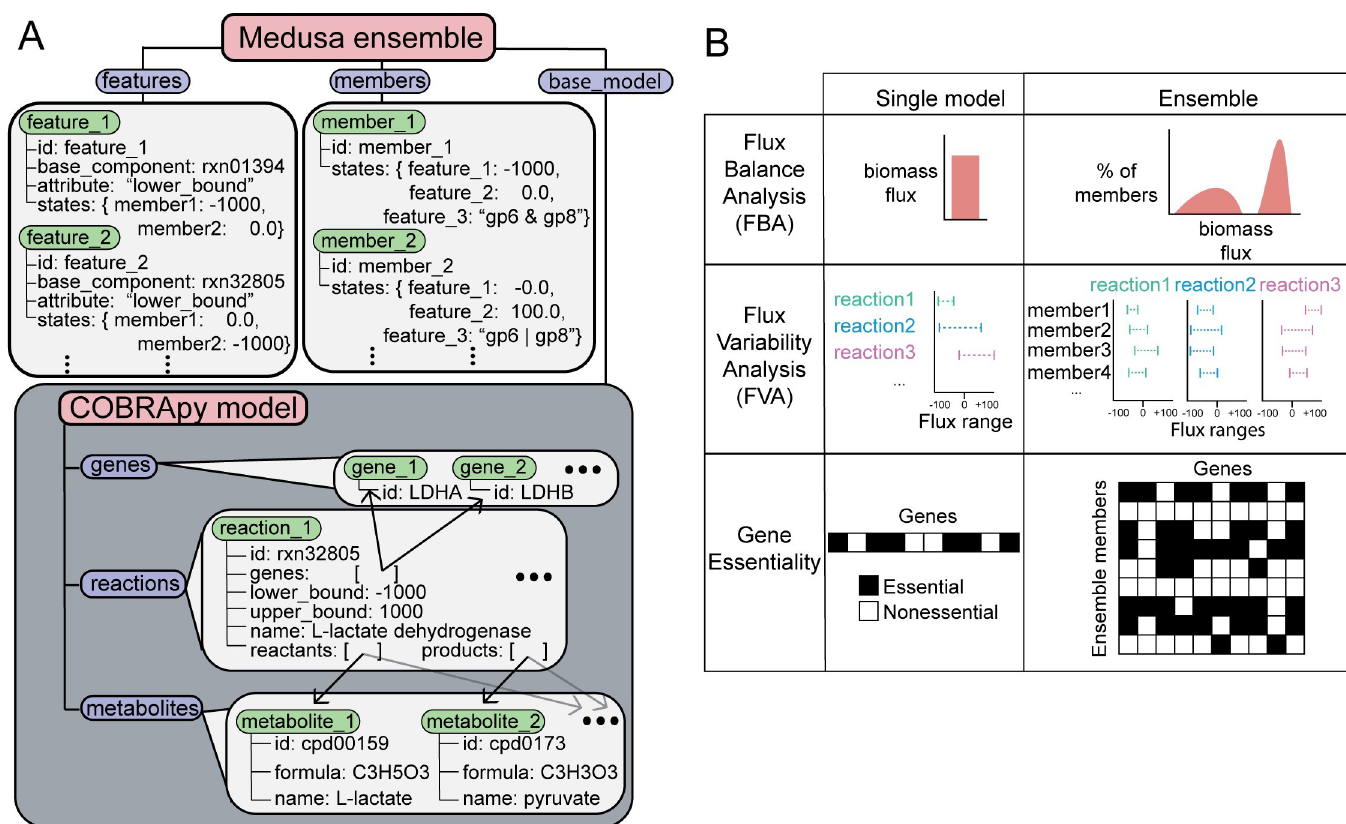
Fig 1. Architecture of ensembles and simulation output in Medusa. A) Ensemble functionality is implemented in Medusa through the Ensemble class. The Ensemble class exposes three attributes to the user: features, members, and base_model. Both features and members are container-like objects similar to genes, reactions, and metabolites in COBRApy. Within each container, Medusa objects of class feature and member are stored. The base_model attribute points to a COBRApy model. This base_model contains all of the features present in any member of the ensemble, and is manipulated when generating an ensemble or performing simulations. B) Description and shape of simulation results for common COBRA methods as implemented in Medusa. Each simulation method returns a distribution-equivalent to the single-model simulation result.